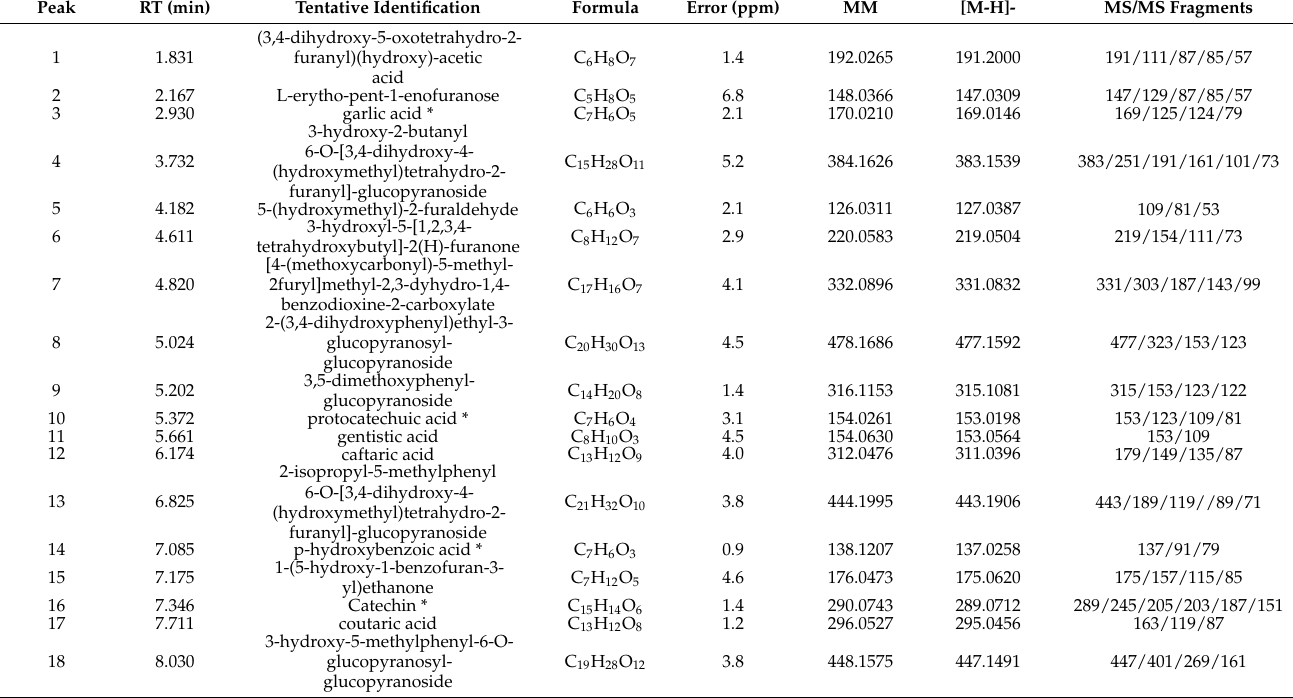
Table 1. Compounds tentatively identified in Msalais wine via